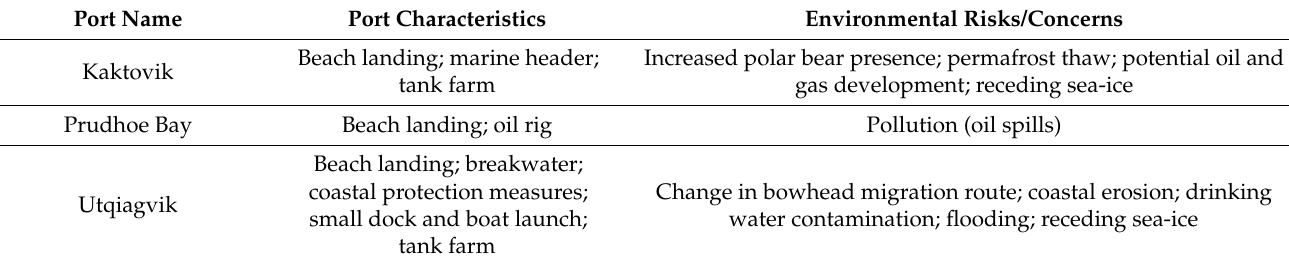
Table A1. Summary table of U.S. Arctic coastal ports.